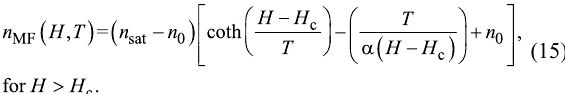
shifted to longer wavelengths when the length ( L 1 , L 2 ) of the stubs increases or when the width ( W 1 , W 2 ) of stubs decreases (Figure 4b–e). The resonance wavelength of peak II is strongly influenced by the two stubs. This indicates that peak II is related to the stub 1 and stub 2. The simulated results confirm the theo- retical